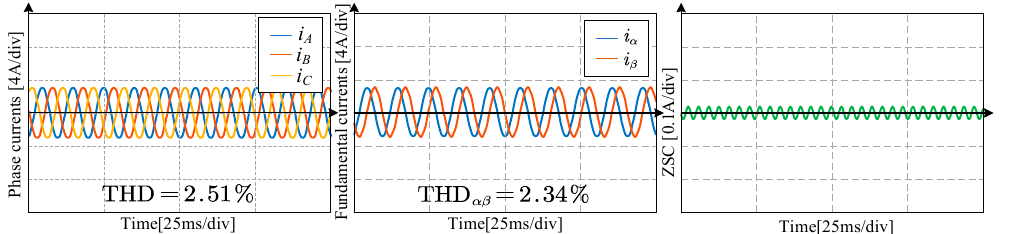
Figure 15. Simulation steady-performance of the conventional controller under 1550 rpm reference.